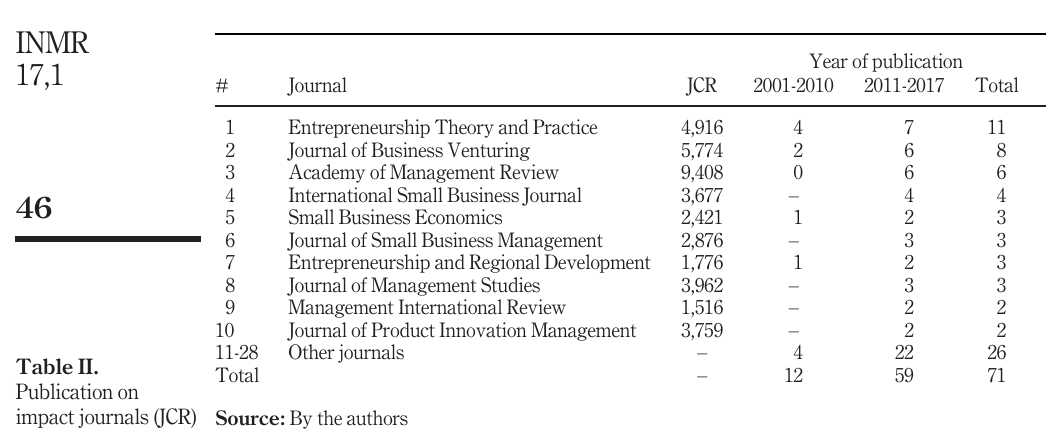
Table II. Publication